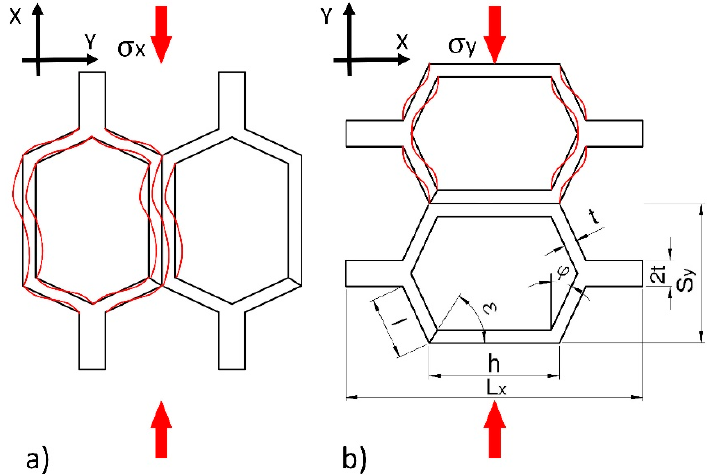
Figure 7. Method of deforming hexagonal cells during axial compression: ( a ) Towards common cell walls, ( b ) perpendicular to the common cell walls.